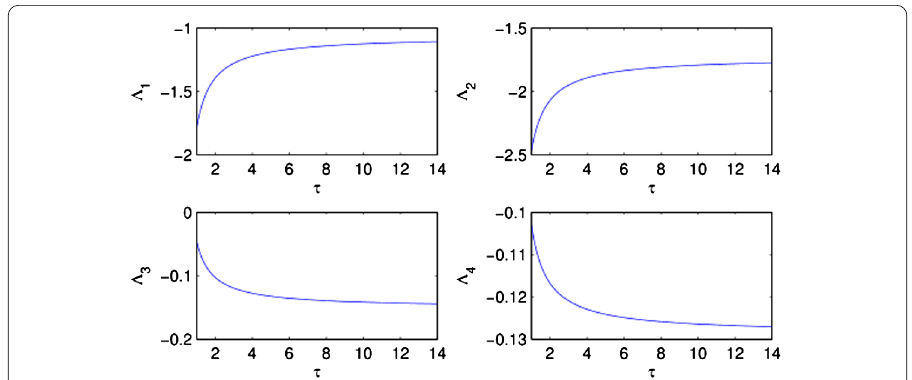
Figure 1 τ versus (cid:19) 1 , (cid:19) 2 , (cid:19) 3 , (cid:19) 4 have been plotted, where all the (cid:19) 1 , (cid:19) 2 , (cid:19) 3 , (cid:19) 4 are negative for τ ≤ τ 0 = 13.9858